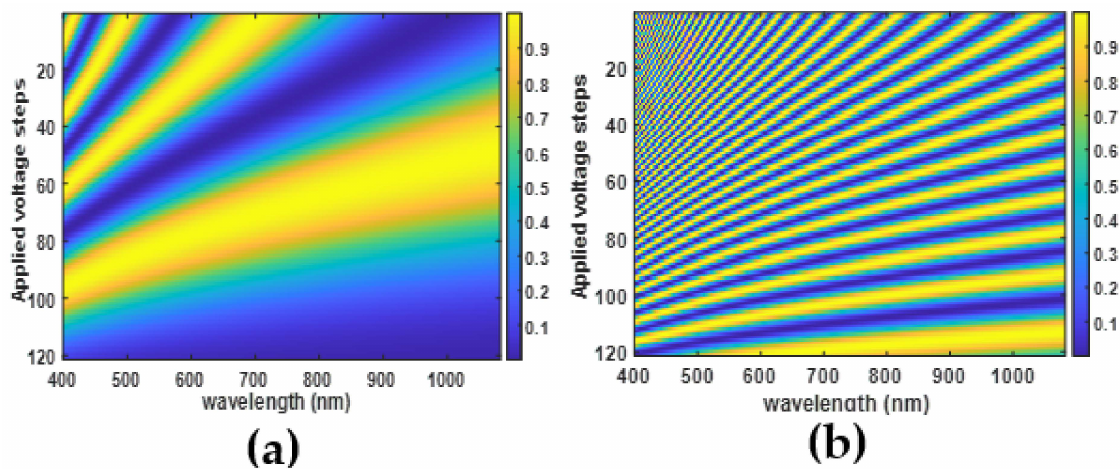
Figure 3. Simulation of spectral modulations of NLC devices using E7 NLC parameters at different applied voltages for two NLC thicknesses: ( a ) 5 µ m and ( b ) 50 µ m while the color of the fringes represents the transmission coefficient